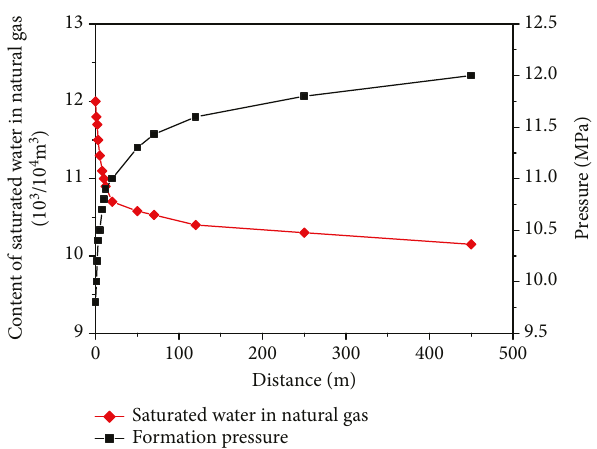
Figure 7: Saturated water content distribution curve of BS8 formation gas.